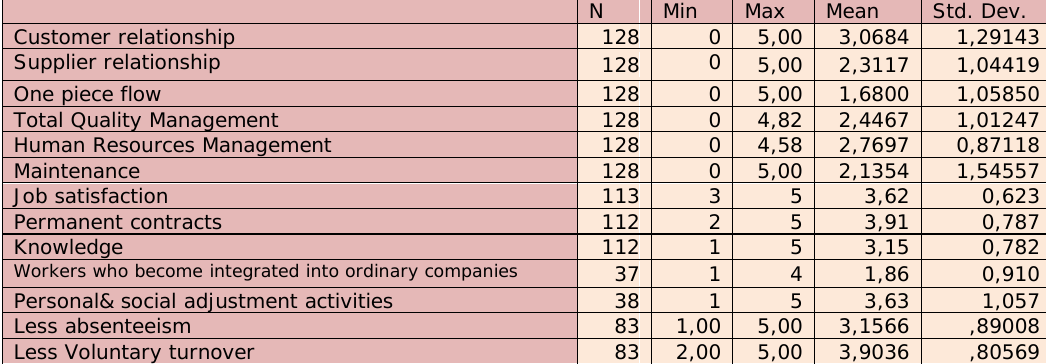
Table 2. Descriptive Statistics of